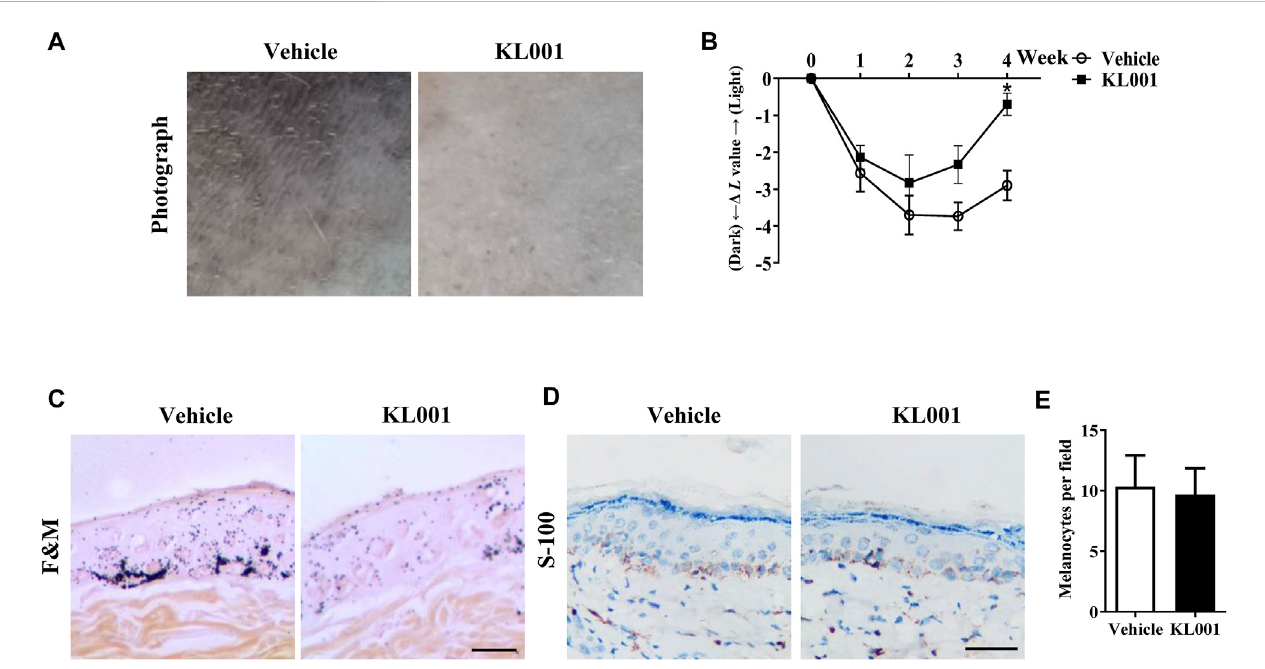
FIGURE 7 KL001 reduced UVB-induced hyperpigmentation in brown guinea pig. (A) Representative photographs of dorsal skin. (B) The degree of depigmentation wasdeterminedbyachromameterfollows: Δ L=L(ateachdaymeasured) — L(atday0).Anincrease inthe Δ Lvalueindicatesadecreaseinhyperpigmentation induced byUV. (C) Fontana-Massonstainingofskinbiopsies. (D,E) Immunohistochemicalstainingofskinbiopsiesforthedetection ofS-100asamelanocyte marker protein. Bar = 50 μ m * p < 0.05 versus non-treated cells.